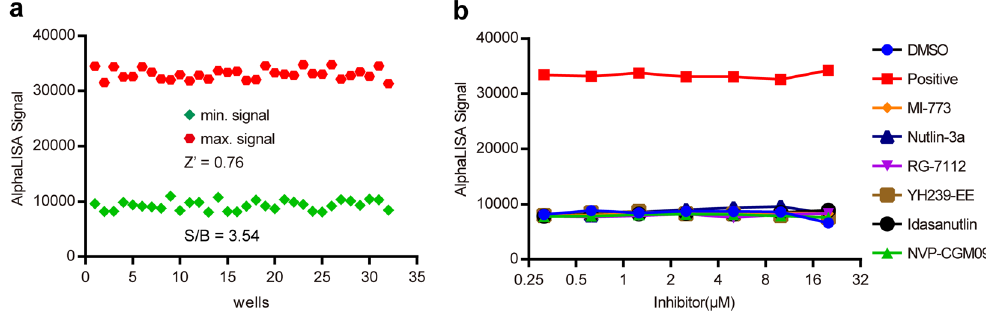
Figure 5. Development of an AlphaLISA based MDM4-inhibitor screening assay and the specificity of the assay. ( a ) Robustness of the MDM4-inhibitor screening assay. AlphaLISA signals of 32 positive controls with optimal amounts of cell extracts containing GST (max. signal) and 32 negative controls with the same amount of cell extracts containing MDM4-GST (min. signal) were plotted. ( b ) Dose-response curves for a few MDM2